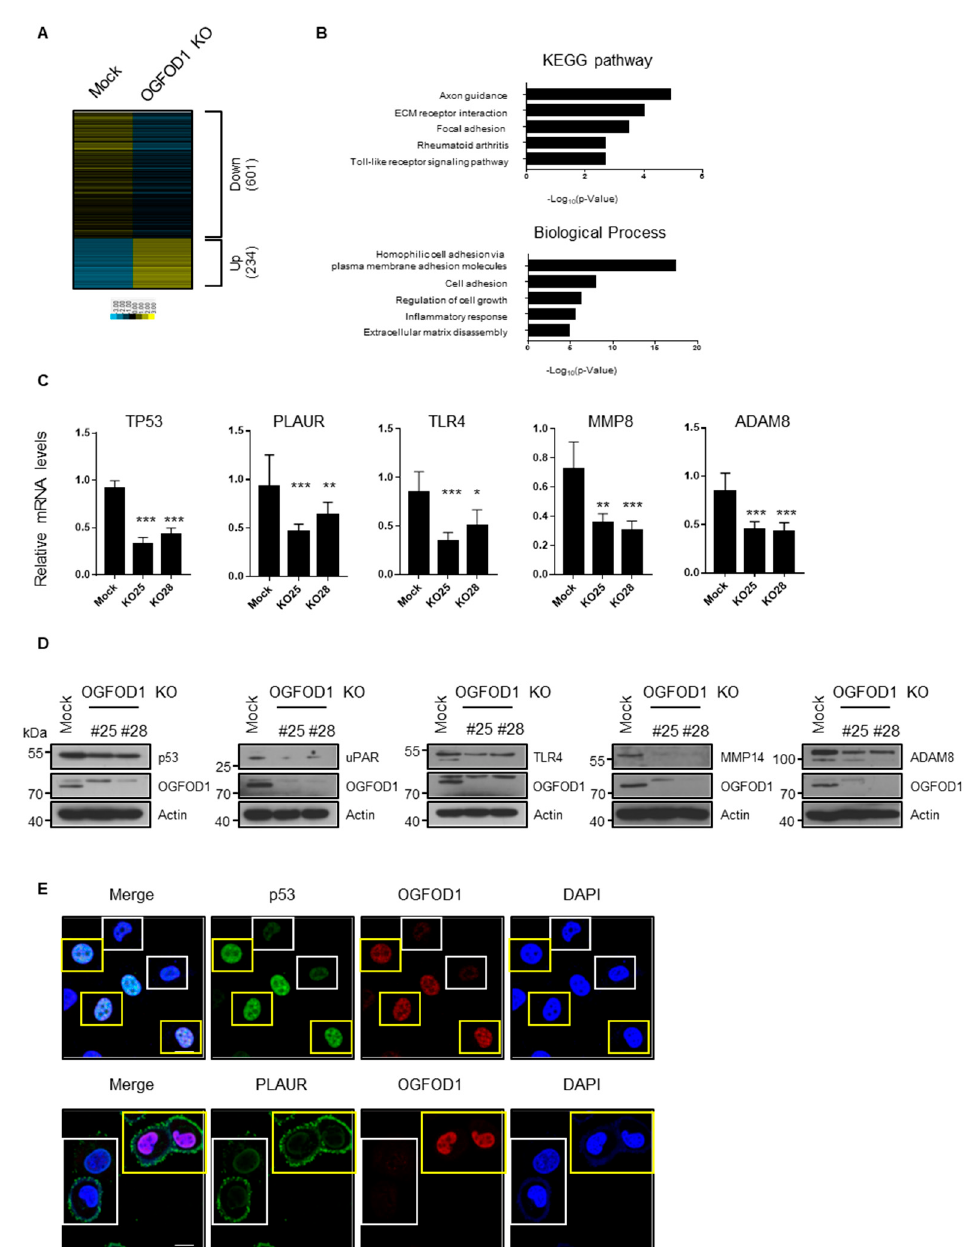
Figure 4. Altered genes by OGFOD1 knockout in MDA-MB-231. ( A ) Heatmap of altered genes by OGFOD1 knockout. Read per kilobase of transcript, per million mapped reads was transformed to log 2 values by Spearman rank correlation. ( B ) The functional gene ontology (GO) analysis of downregulated genes. ( C ) qRT-PCR results of reduced genes. mRNA levels were confirmed in two other knockout clones. ( D ) Protein levels of reduced genes were confirmed in two other knockout clones. ( E ) Confocal images of p53 and PLAUR in mixed culture of wild-type (Mock) and OGFOD1 KO MDA-MB-231. Yellow and white boxes indicate wild type and OGFOD1 KO, respectively. Scale bar indicates 20 μ m. * p < 0.05, ** p < 0.01, *** p < 0.001.